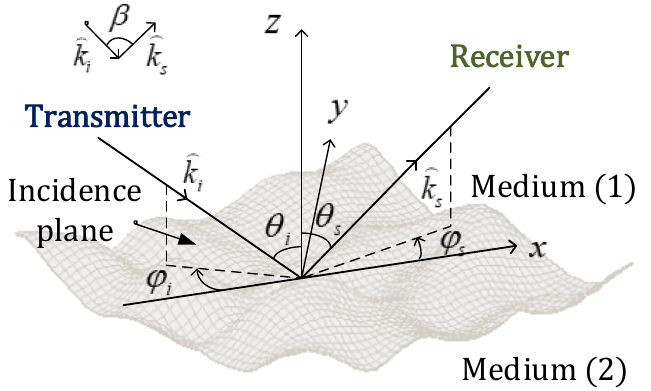
Figure 1. Bistatic scattering geometry.